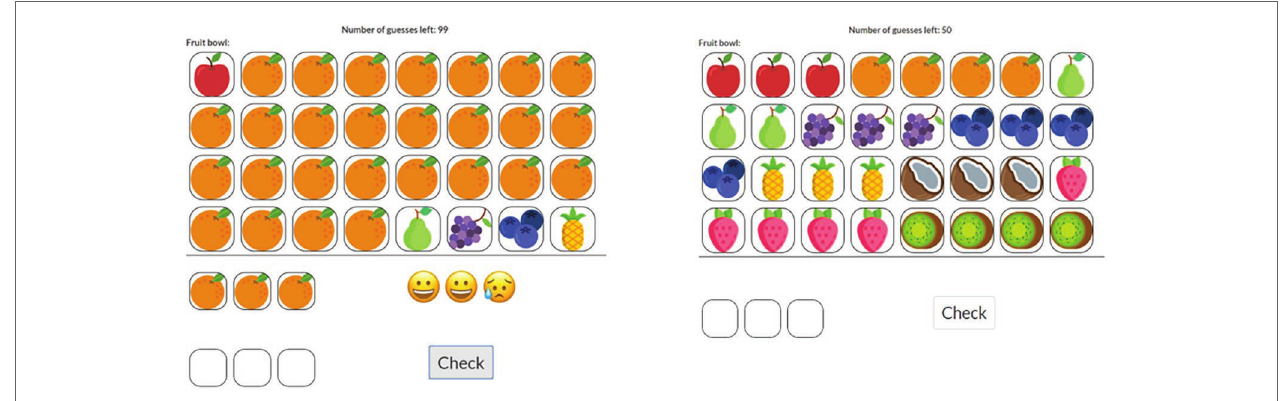
FIGURE 1 | Icon arrays representing two example code jars (in this version of the game fruit bowls) which generated the secret code. Left panel : low entropy code jar. The first guess and the corresponding feedback are displayed. Happy emoticon: correct fruit and correct position; neutral emoticon: correct fruit but wrong position; sad emoticon: incorrect fruit and position. Positions of faces do not correspond to positions in the code. Right panel : high entropy code jar. Game environment before the first guess was entered. Initially, each position of the code is blank, and players can cycle through the fruits by clicking on the blank field. Feedback is provided after players clicked on the “Check” – button. Play the game yourself: http://jonathandnelson.com/curious/masterminding.html.